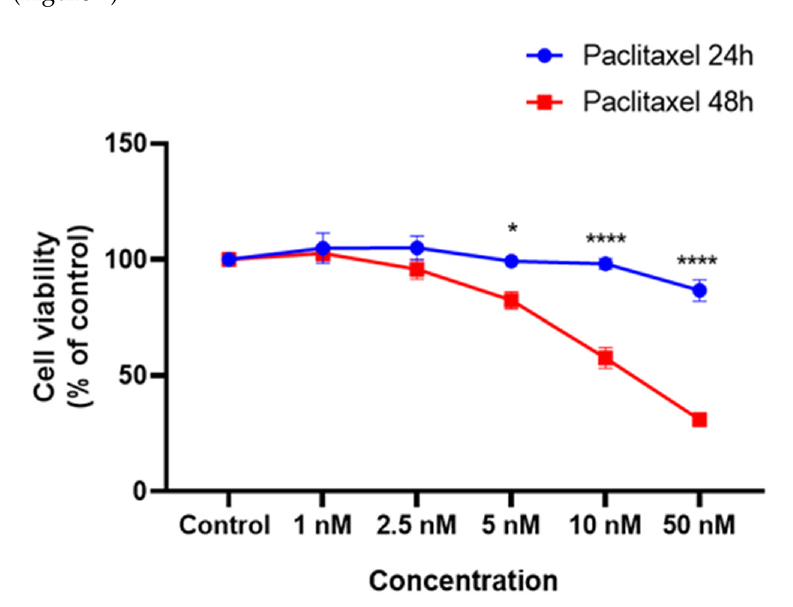
Figure 7. Comparison of the cell viability (% of control) between the 24 h and 48 h of exposure to paclitaxel. Results are expressed as mean ± standard error of the mean (SEM). * p < 0.05, **** p < 0.0001.